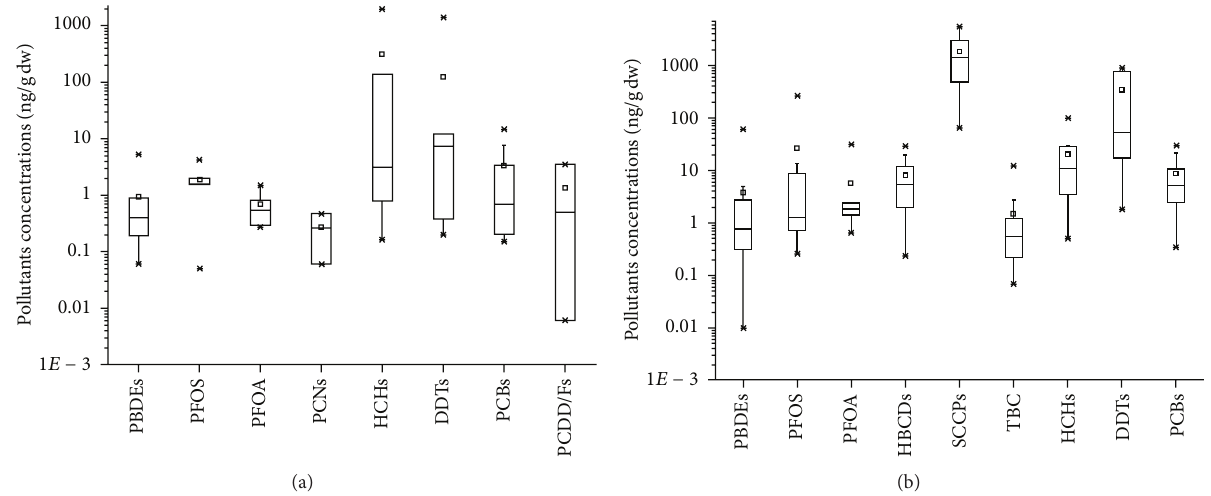
Figure 2: (a) Legacy POPs and emerging pollutants in Bohai Sea sediments. The upper and lower quartiles of the boxes represent 25th and 75th percentiles of the data, and three horizontal bars represent the maximum, median, and minimum values; “ × ” and “ ⬞ ” denotes outliers and mean. (Data source: PBDEs [14, 15, 17, 18, 20]; PFOS [23, 24]; PFOA [23, 24]; PCNs [27]; HCHs [6, 84, 85]; DDTs [6, 85–88]; PCBs [15, 19, 87, 89]; PCDD/Fs [84, 89]). (b) Legacy POPs and emerging pollutants in Bohai Sea organisms. The upper and lower quartiles of the boxes represent 25th and 75th percentiles of the data, and three horizontal bars represent the maximum, median, and minimum values; “ × ” and “ ⬞ ” denotes outliers and mean. (Data source: PBDEs [14, 35–37, 40]; PFOS [23, 41]; PFOA [23, 41]; HBCDs [36]; SCCPs [44]; TBC [36]; HCHs [9, 35, 37]; DDTs [9, 52]; PCBs [11,